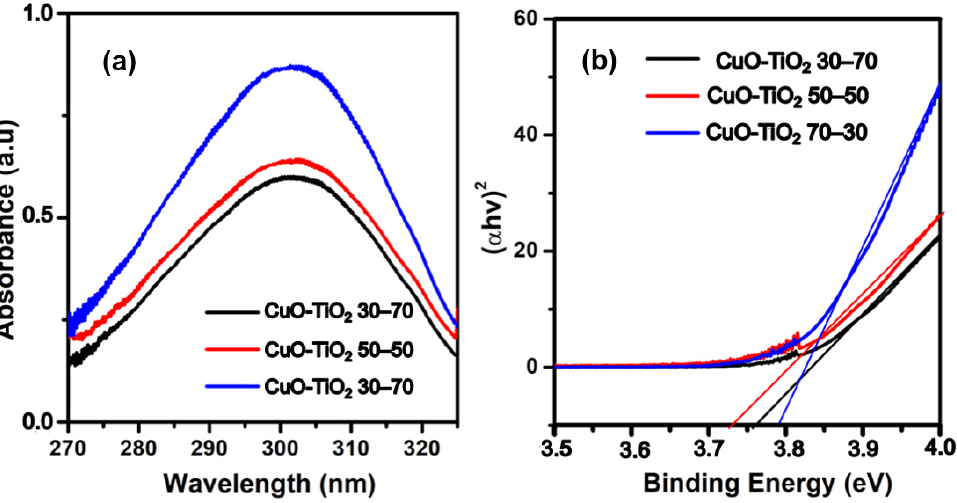
Figure 2. ( a ) UV ‐ vis curves for CuO ‐ TiO 2 (30/70, 50/50, and 70/30) and the corresponding ( b ) Tauc’s